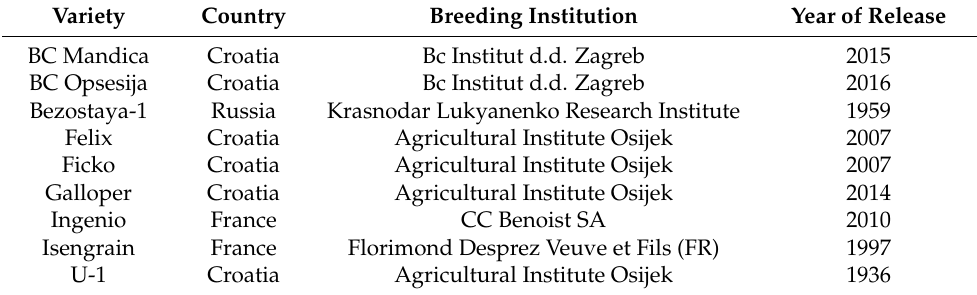
Table 5. Soil nitrogen (N) content (kg ha − 1 ) in Osijek in 2017/18 year. Location Soil Type